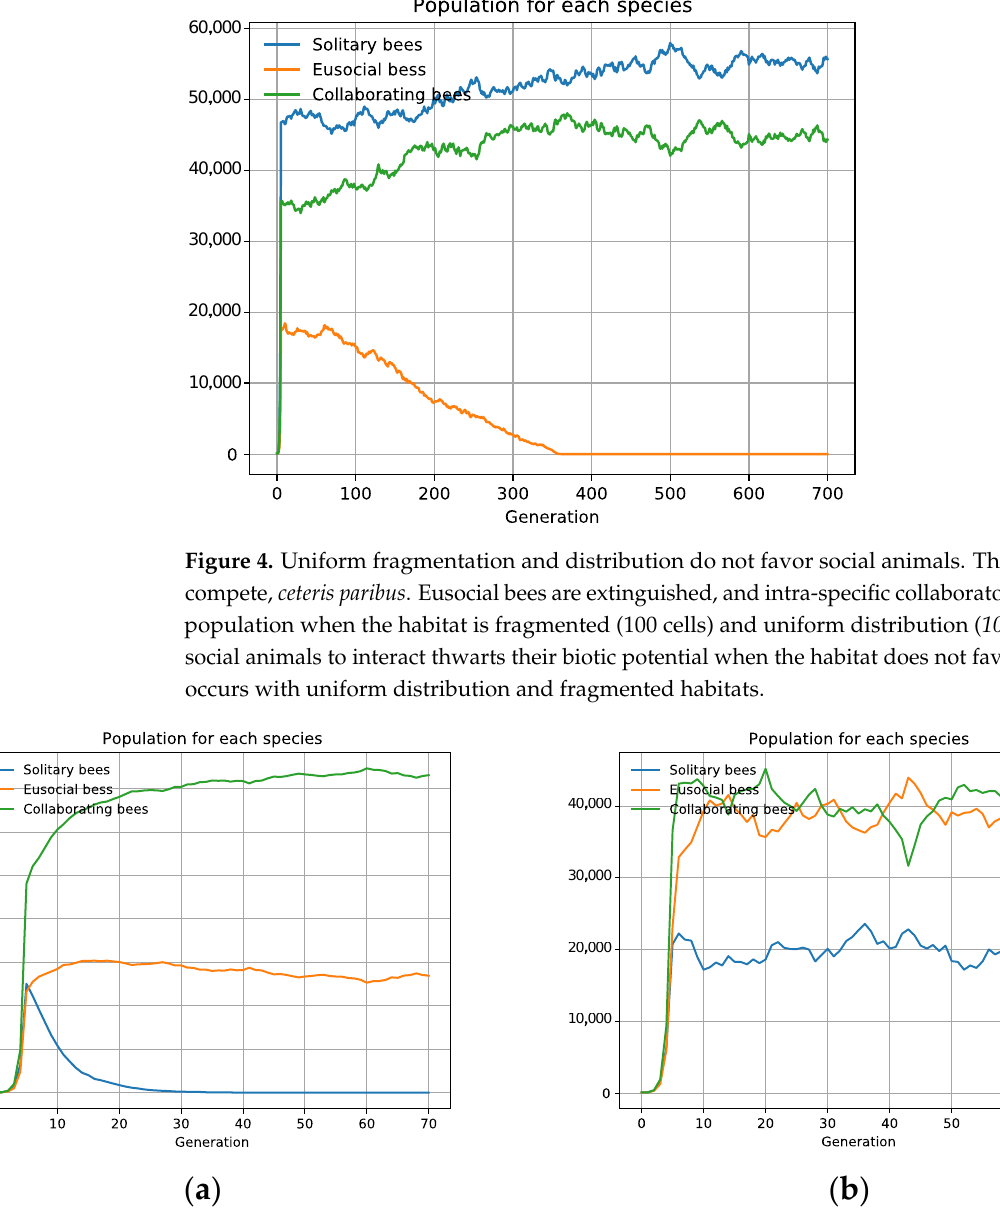
Figure 4. Uniform fragmentation and distribution do not favor social animals. Three types of bees compete, ceteris paribus . Eusocial bees are extinguished, and intra-specific collaborators have a